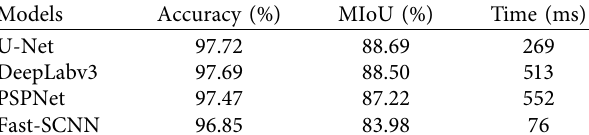
Table 4: Segmentation results of sheep carcass on the ICNet model. Models